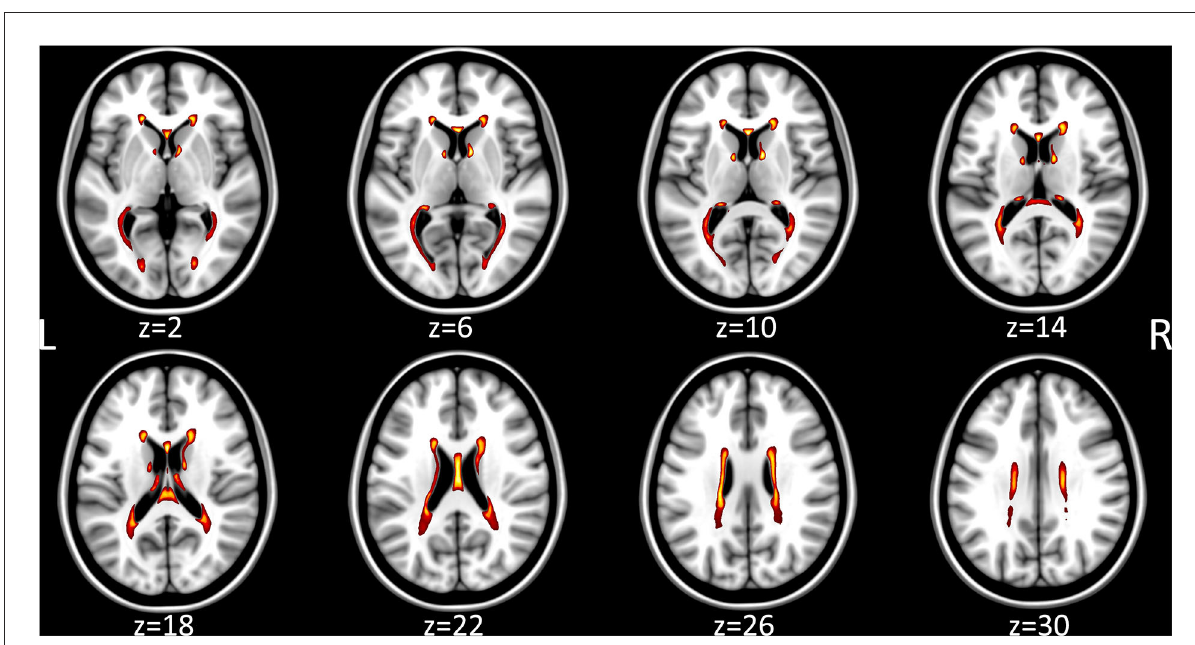
FIGURE2 Heatmap of the individual multiple sclerosis lesion maps, which were transformed into MNI template space, averaged voxel-wise, thresholded to 25% and color-coded (white 100% overlap, red 25% overlap). Axial slice position is indicated below the MRI respectively.